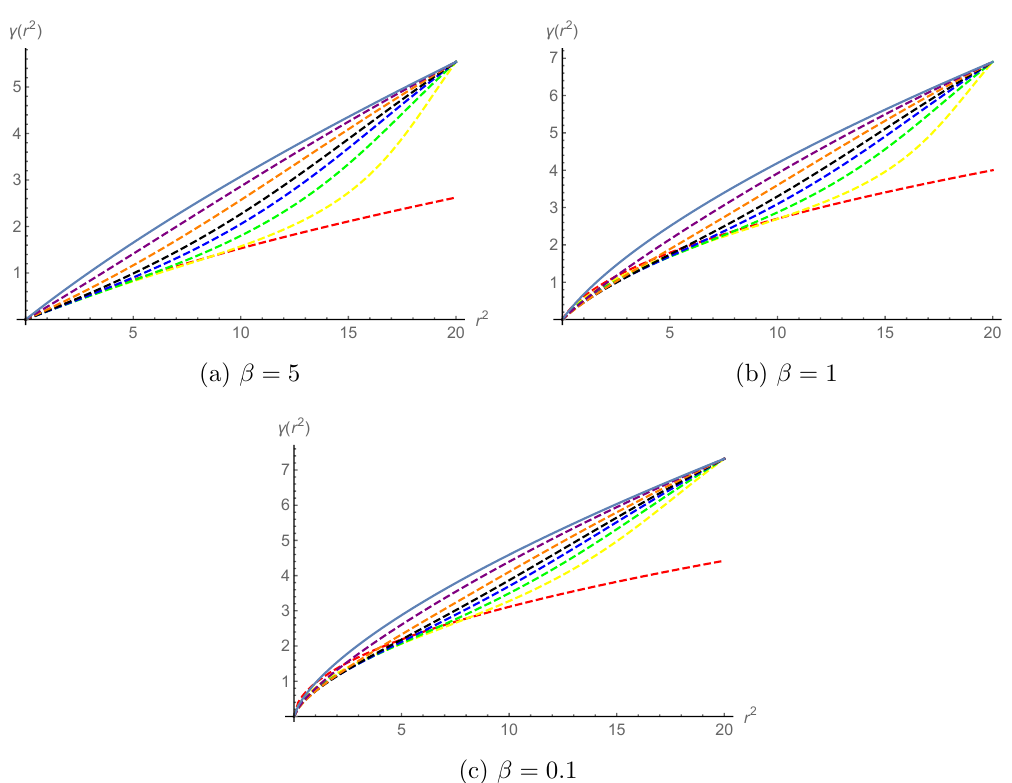
p (cid:12) 2 + 4 r 2 (red